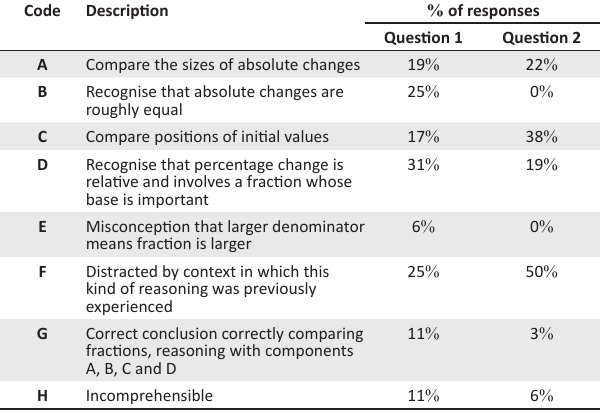
TABLE 2: Results of coding of responses to Question 1 ( N = 36) and Question 2 ( N = 32). Code Description